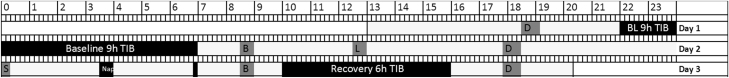
Schematic represents study protocol. Time of day is presented across the X-axis, from midnight to midnight on Study Days 1, 2, and 3. Black boxes represent time in bed opportunities (TIB). The TIB opportunity ending at 04:00 h represents the 30-minute and 10-minute night time nap for each nap condition respectively (30-NAP; 10-10-NAP). The TIB opportunity ending at 07:00 h represents the 10-minute morning nap opportunity for the 10-10-NAP condition. Meals are shown in the grey boxes (B= breakfast, L=lunch, D=dinner, S=Snack). Across both snack conditions, each breakfast comprised of ~2100 kJ, lunch comprised of ~2700 kJ and each dinner comprised of ~3400 kJ. The big snack condition comprised of ~2100 kJ and the small snack condition comprised of ~840 kJ.